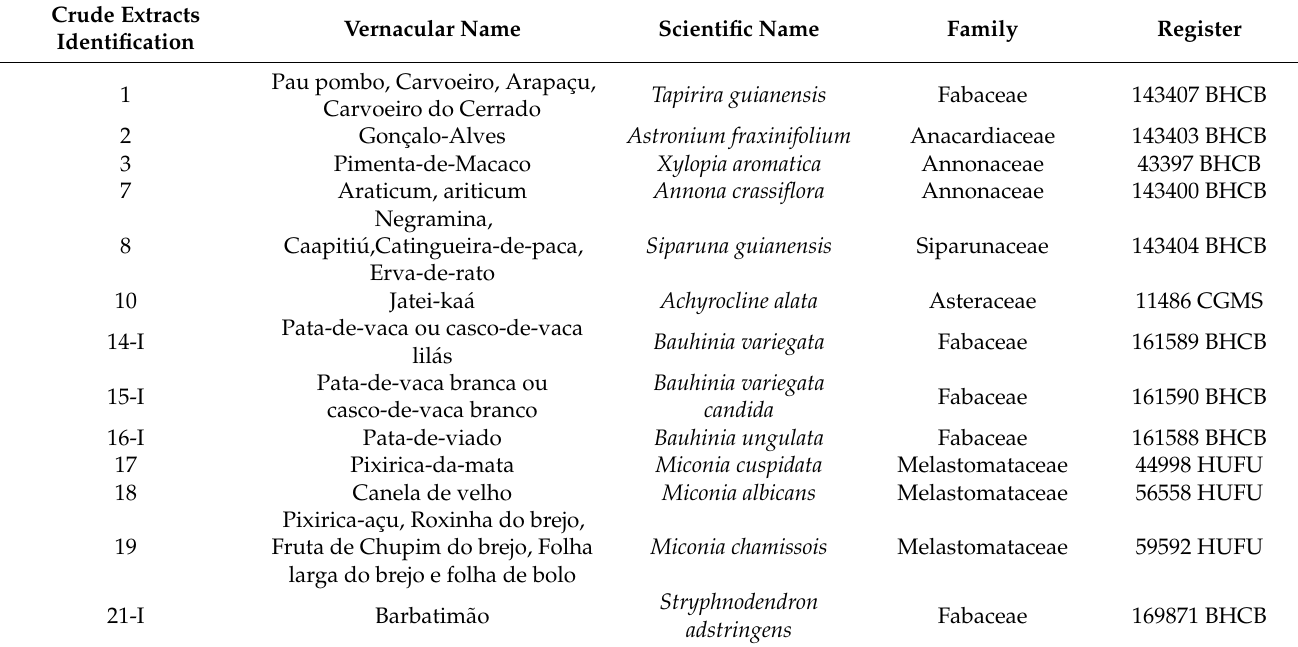
Table 7. Characteristics of the Cerrado plant